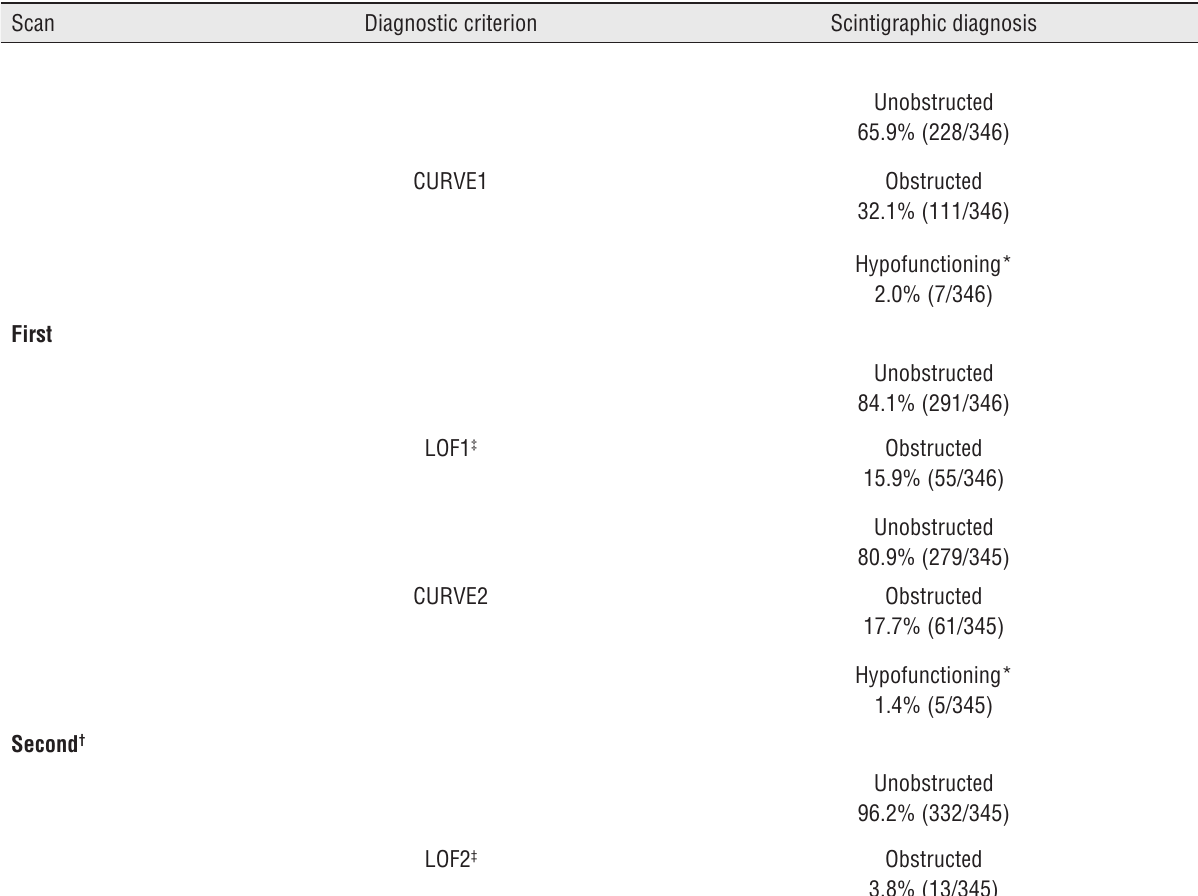
cURvE1 and 2: renal curves in the first and second scans. LOf1 and 2: output fraction in the first and second scans. * severely hypofunctioning kidneys not allowing differentiation by curve analysis between obstruction and non obstruction. † one unilateral nephrectomy between the first and second